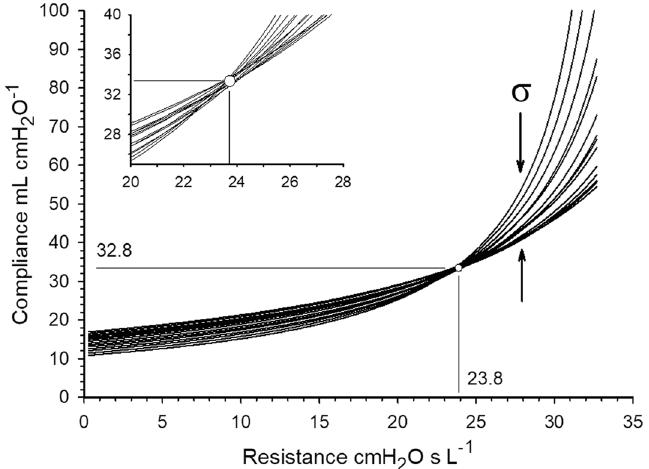
Fig. 2 A family of C rs and R rs functions ( n 14). Each function was generated at different times ( t k ) = measured sequentially at 32 ms during a single insufflation. The intersection of these functions